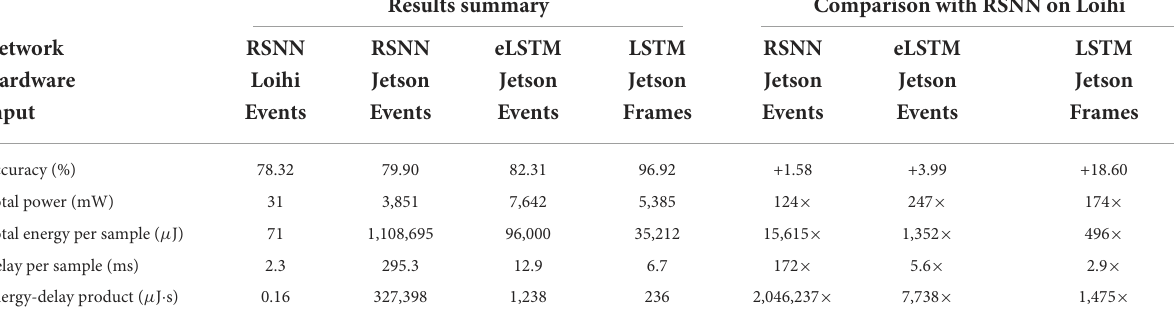
TABLE 4 Results summary from RSNN on Loihi and RSNN, eLSTM and LSTM on Jetson for accuracy, total power, energy per sample, delay and energy-delay product. Results